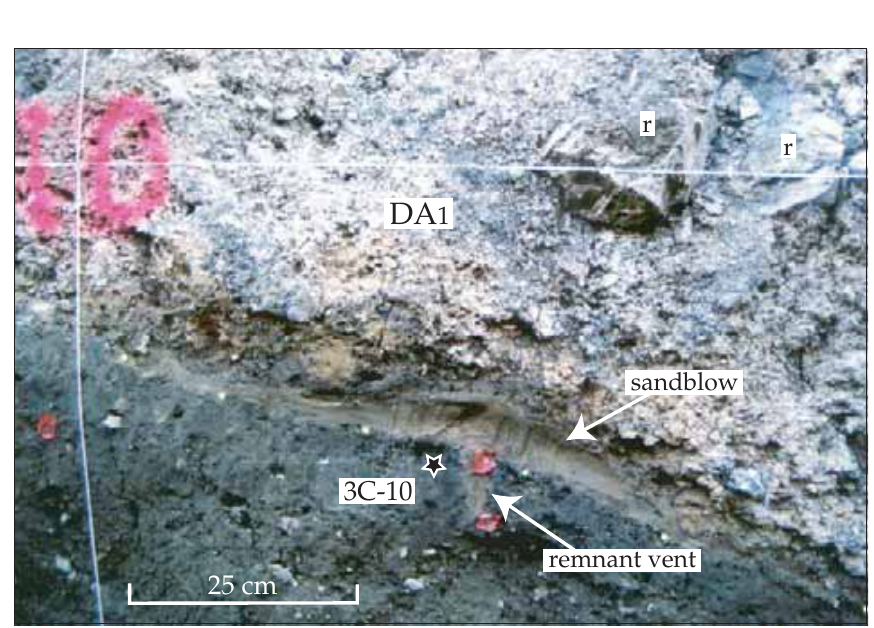
Fig. 10. Photo of trench stratigraphy at metre 10, including sandblow deposit and remnant vent (arrowed), over- lying the lateral equivalent unit to paleosol (P 1 ), the top of which forms the event horizon for Event II, and the overlying debris avalanche deposit, DA 1